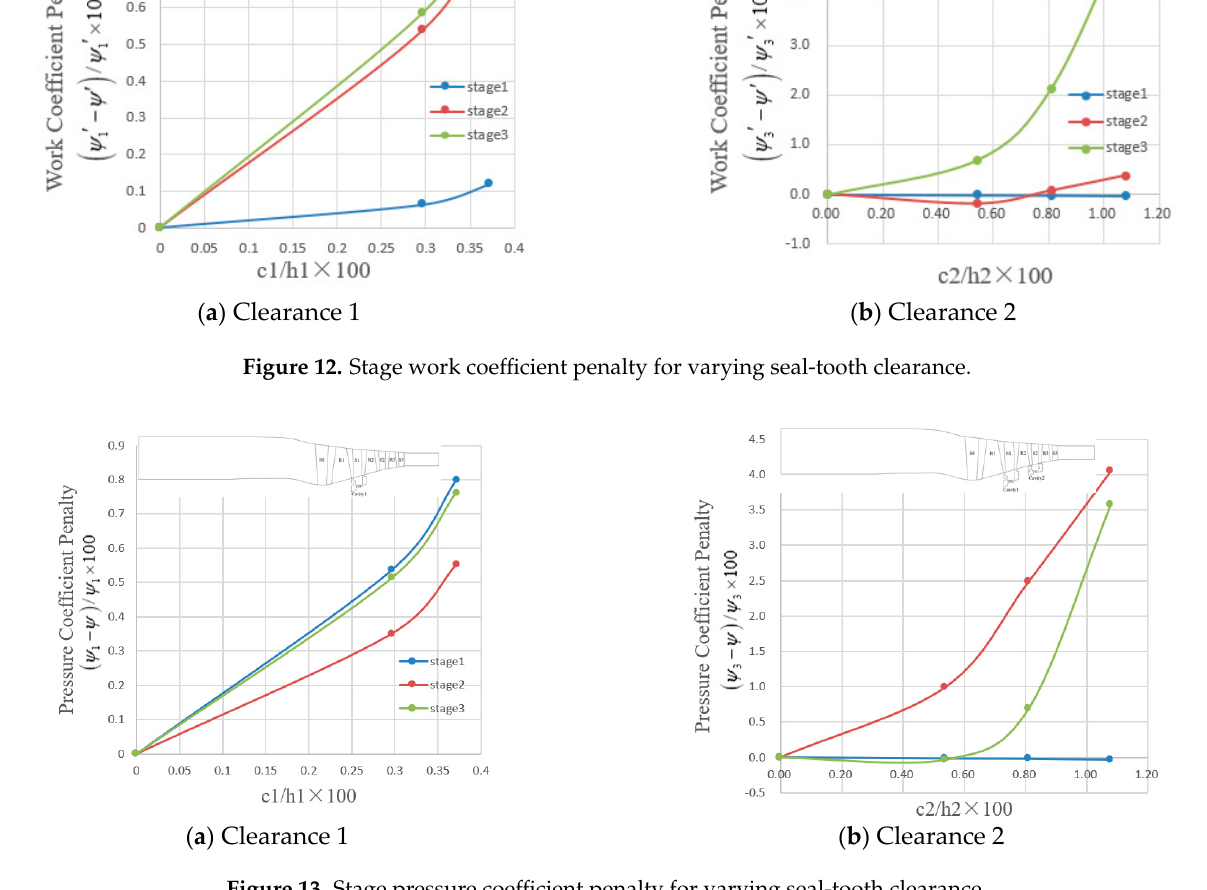
Figure 13. Stage pressure coefficient penalty for varying seal-tooth clearance.